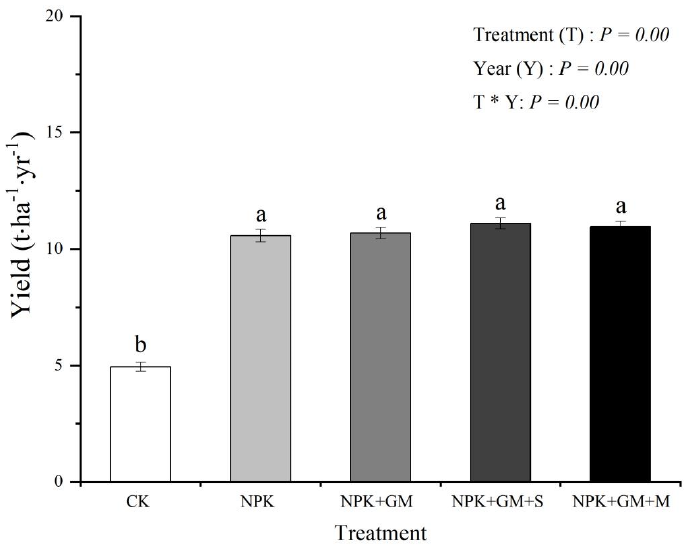
Figure 2. Effects of different treatments on rice yield.